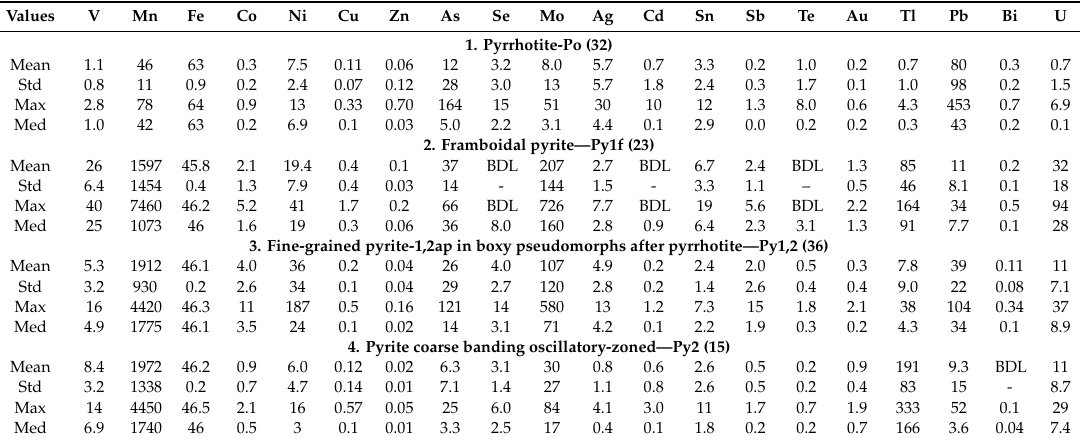
Table 4. Trace element concentration in pyrrhotite and varieties of pyrite of microfacies-195. Pobeda vent site. LA-ICP-MS data in ppm. Fe, Cu, and Zn are in wt.% (samples 37L-195-1, 37L-195-2, and